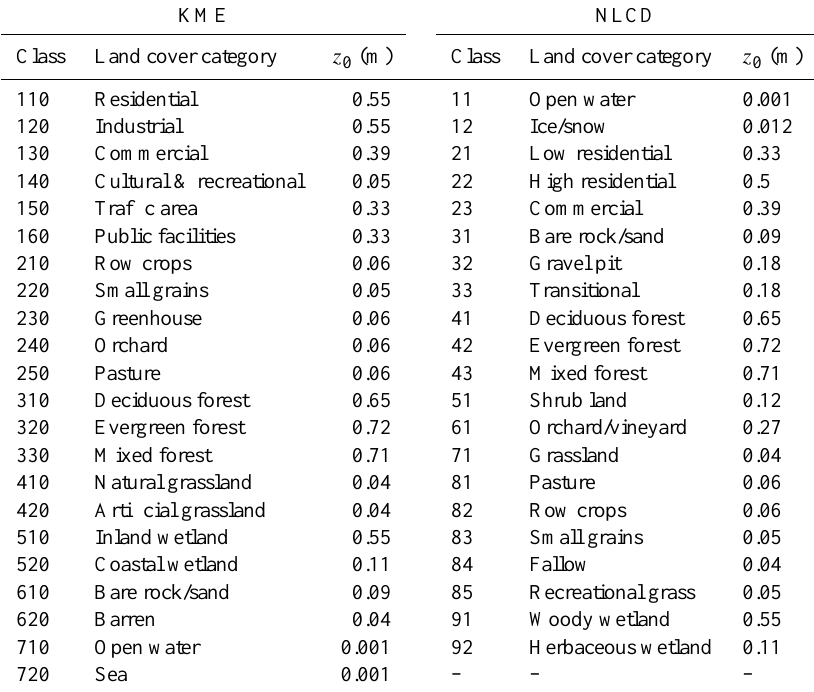
Table 2. A comparison of the nominal surface roughness lengths ( z 0 ) between the KME and NLCD data sources.